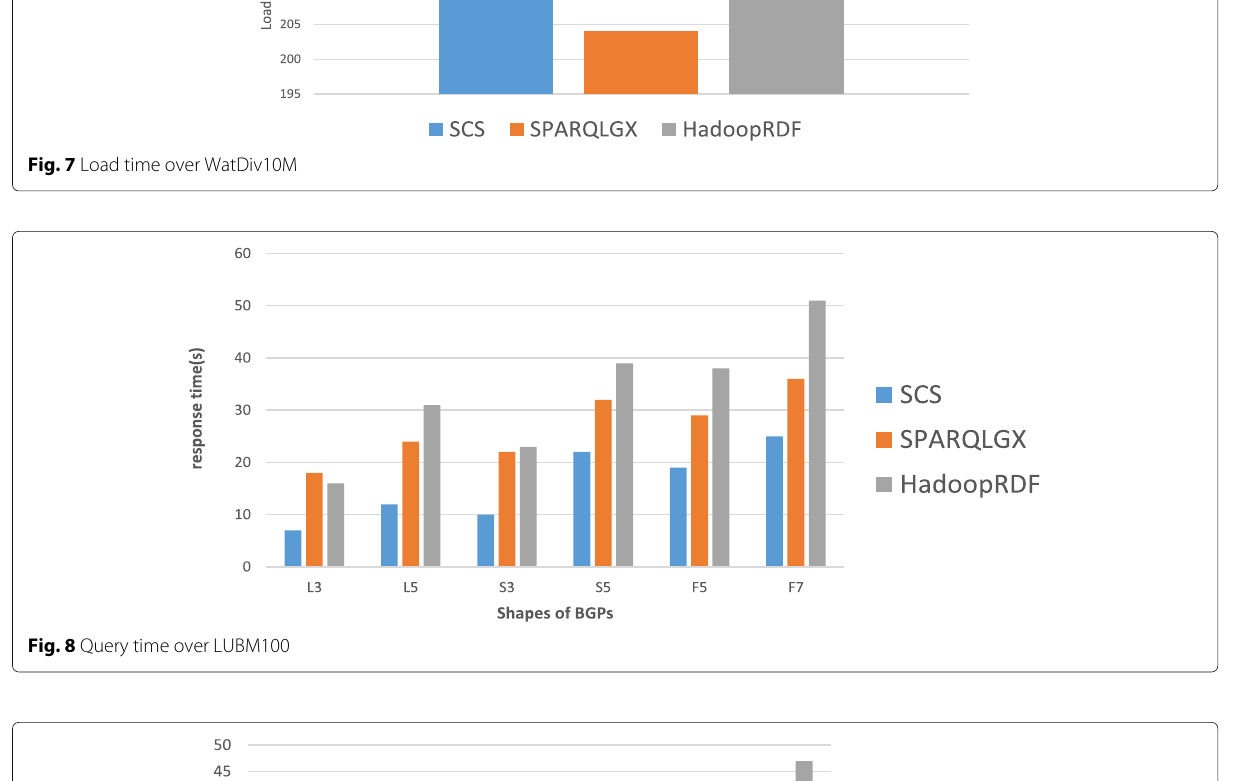
Fig. 6 load time over LUBM100